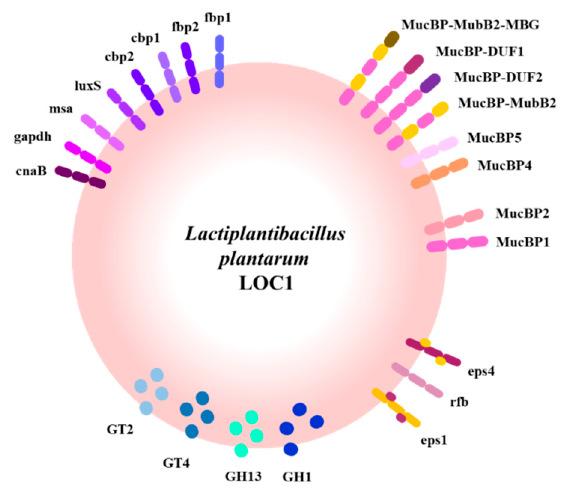
Figure 13. Schematic representation of glycosylhydrolases (GH), glycosyltransferases (GT), adhesion factors and exopolysaccharide (EPS) detected in the Lactiplantibacillus plantarum LOC1 genome. The genome of the LOC1 strain was studied and compared with the probiotic strains WCFS1 and CRL1506 as reference.